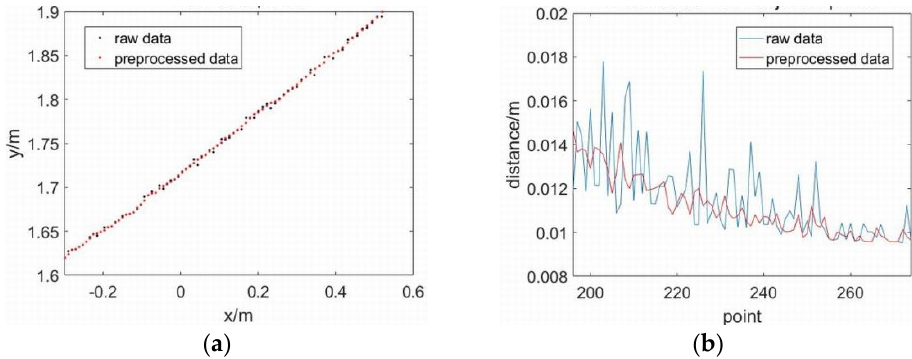
Figure 2. Data preprocessing: ( a ) Radar raw data point set and the point set after denoising; ( b ) radar raw data adjacent point distance and the distance between adjacent points after denoising.